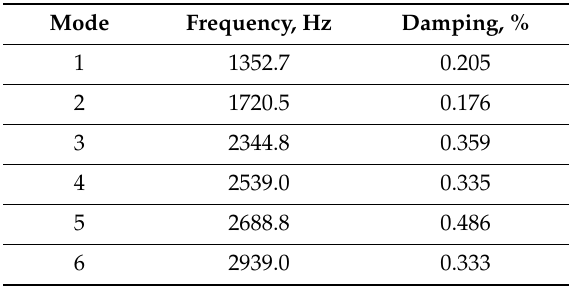
Table 2. Results of the experimental modal analysis.